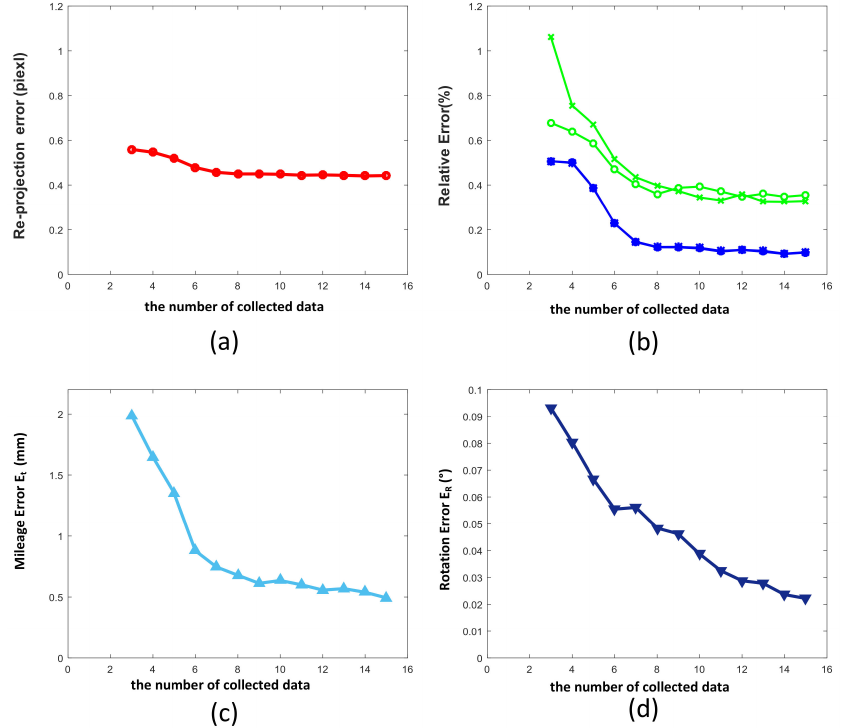
Figure 5. The simulation results for different numbers of collected data. ( a ) Re-projection error E dr ; ( b ) Effects of the number of data on intrinsic parameters such as E fu , E fv , E u 0 , E u 0 ; ( c ) Mileage error E t for different noise levels; ( d ) Effect of the number of data on rotation error E R